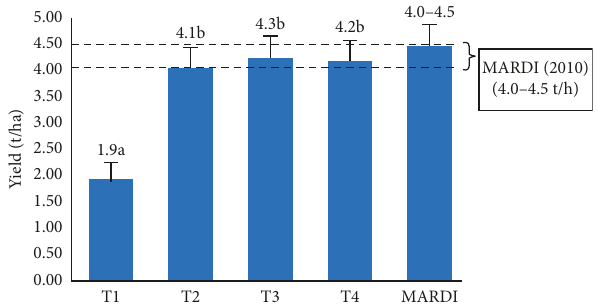
Figure 1: Yield of MRM 16 as affectedby four different fertilizer rates Within a column, means followed by a different letter are significantly different at 0.05 probability level according to the Tukey's significant difference